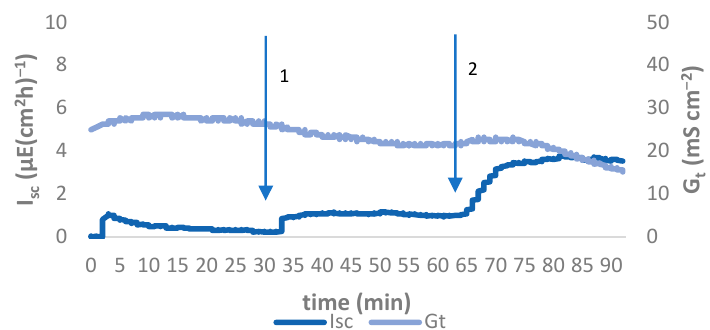
Figure 2. Typical time course of I sc and G t of jejunal epithelium using Ussing chamber experiment of a pig in Group 0. Arrows indicate addition of pharmaceuticals: 1 glucose (mucosal) + mannitol (serosal), 2 forskolin (serosal).